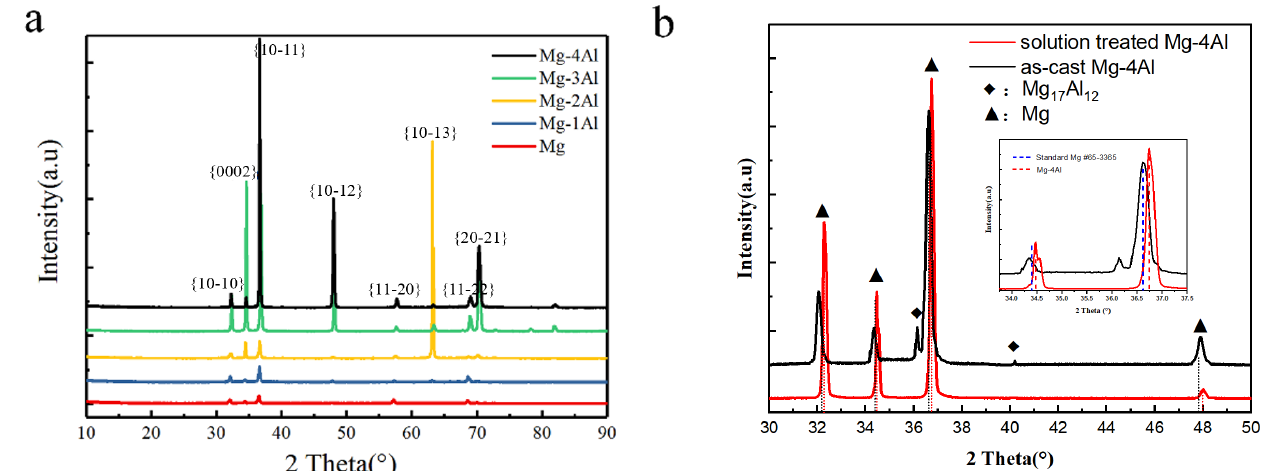
Figure 3. XRD patterns of ( a ) the solution treated Mg–Al alloys with different Al content, ( b ) as-cast and solid treated Mg–4Al alloy.